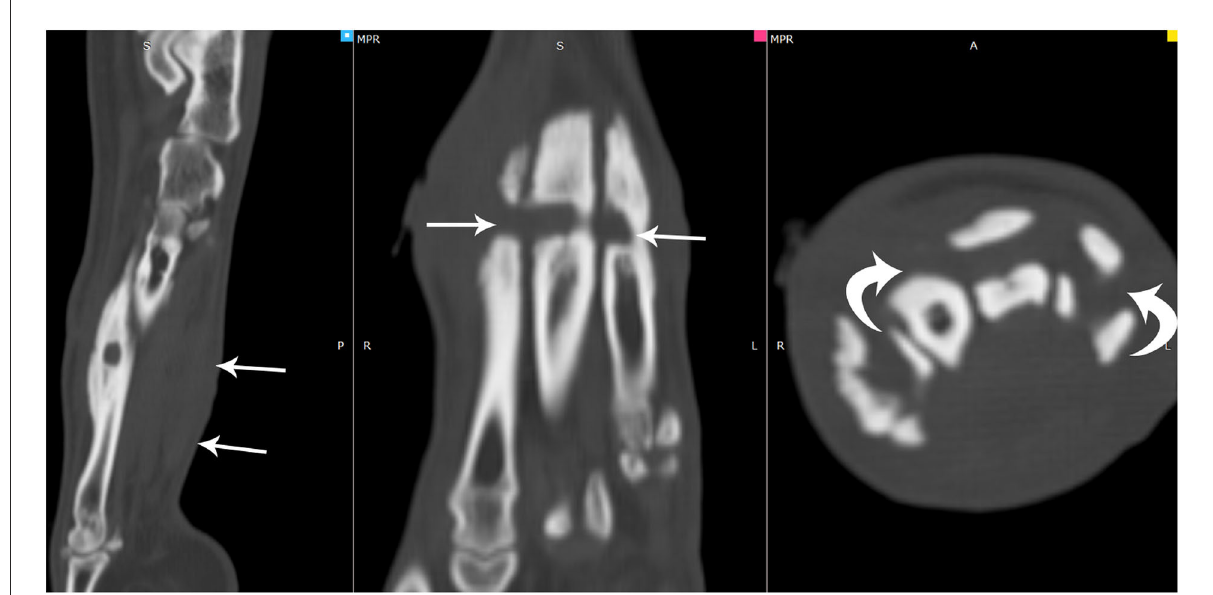
FIGURE3 Multiplanar reformatted images of the computed tomographic in a bone window showed soft tissue swelling noted along the plantar aspect of the metatarsal bones (arrows). In this region, there were well-defined smoothly marginated lucencies that appeared to tunnel horizontally through all metatarsal bones (arrows). Adjacent sclerosis and smoothly marginated new bone were noted along the metatarsal bones in this region.